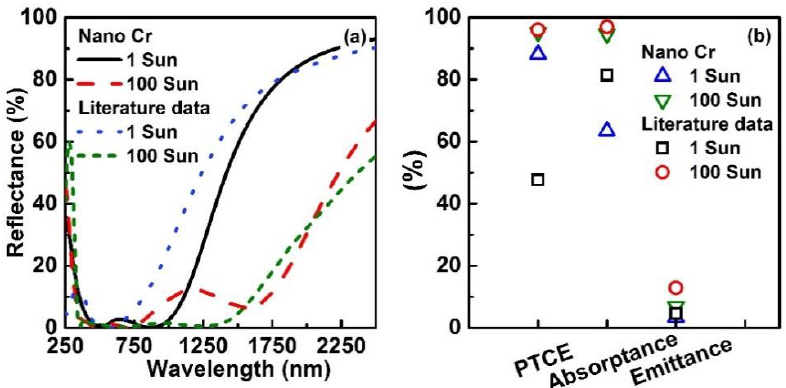
Figure 5. ( a ) Reflectance spectra of the designed six-layer solar selective absorber with Cr layer’s optical constants obtained from the measured ultrathin nano-Cr layer or literature data for bulk Cr layer; ( b ) the solar photothermal conversion efficiency (PTCE), solar absorptance, and thermal emittance of the designed solar selective absorber based on the measured optical constants or the literature data for Cr film.